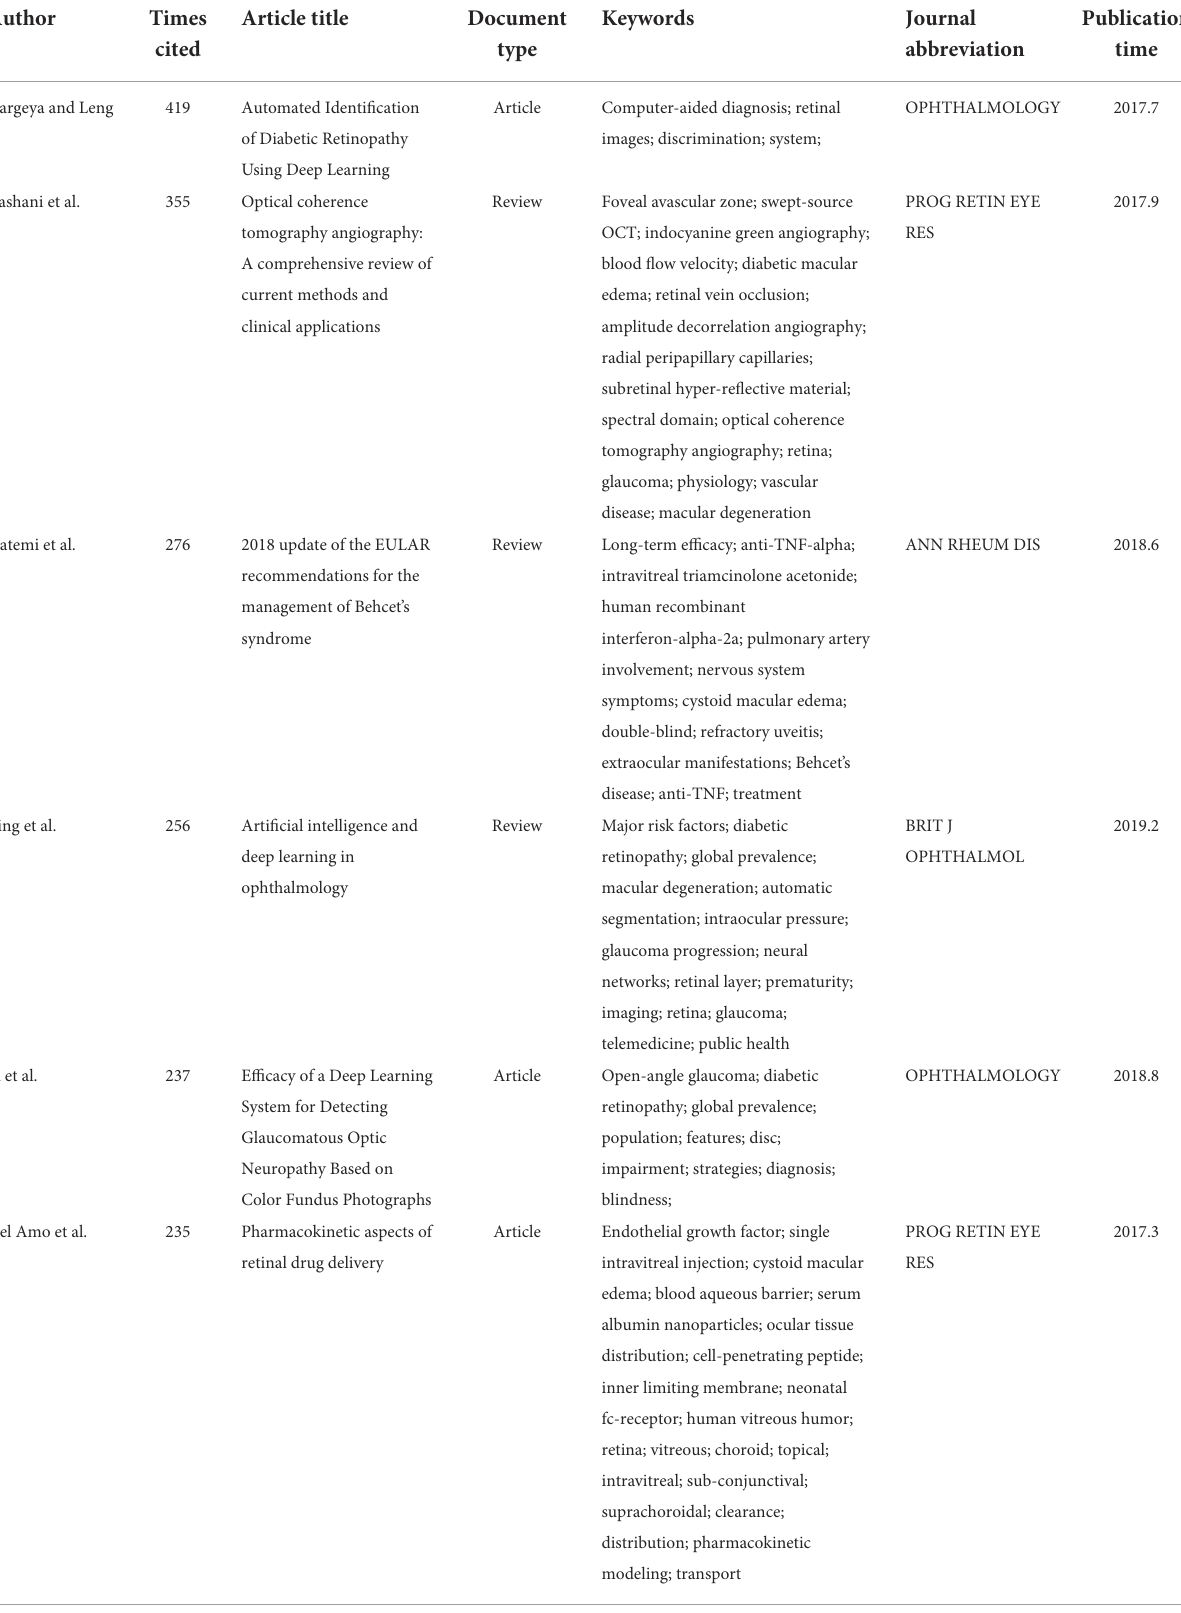
TABLE 1 Top 25 most cited documents published between 2017 and